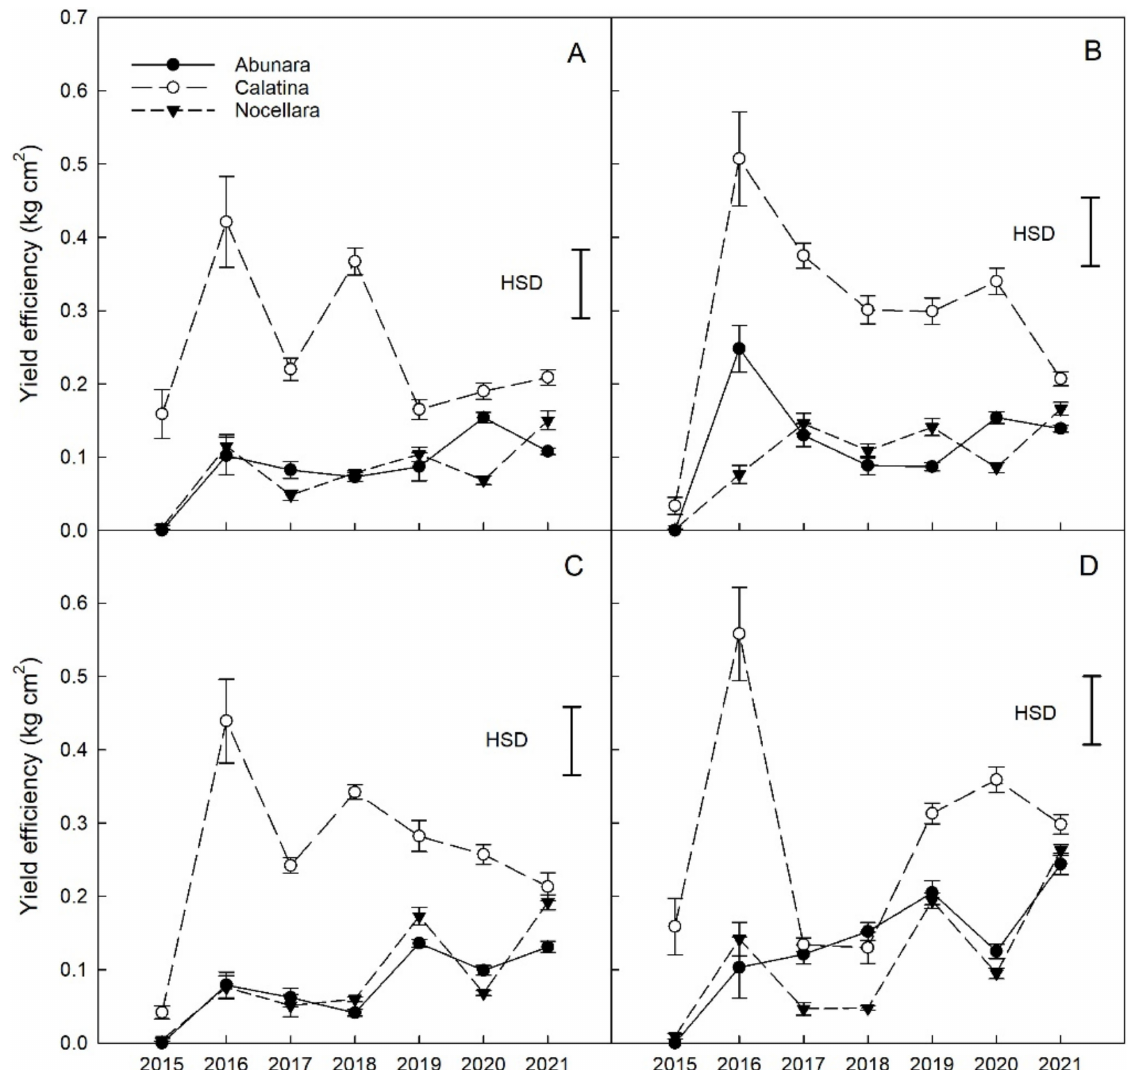
Figure 5. Trends of yield efficiency across the seven years of trial for ‘Abunara’, ‘Calatina’, and ‘Nocellara del Belice’ olive trees grown as central leaders at 2 × 5 m (CLx2, ( A )), free palmette at 3 × 5 m (FPx3, ( B )), globe vase at 4 × 5 m (GVx4, ( C )), and polyconic vase at 5 × 5 m (PVx5, ( D )). Error bars represent standard errors of the means. Mean separation by Tukey’s honestly significant difference (HSD, p <